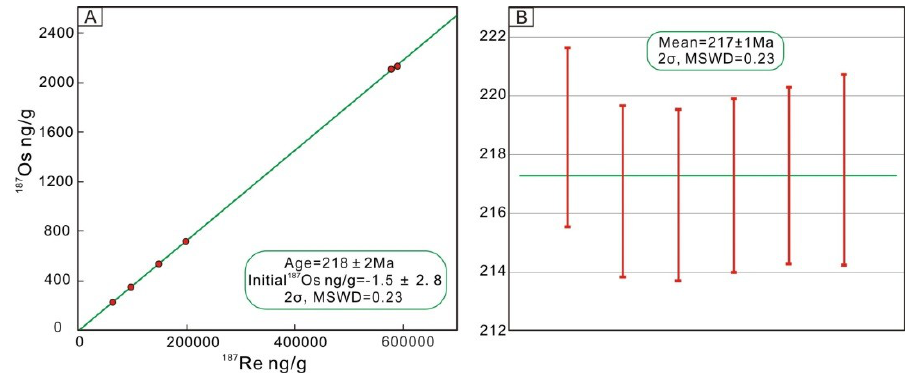
Figure 7. Diagrams of molybdenite Re–Os isochron age ( A ) and weighted mean age ( B ) in the Pulang Cu (–Mo–Au) deposit.